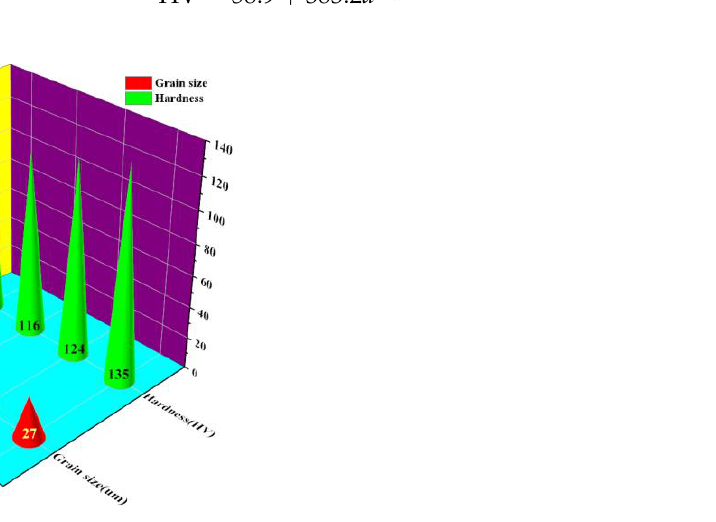
Figure 4. Average grain size and Vickers hardness at different annealed conditions (Fe765, Fe785, and Fe805), with the forged condition (Forg-Fe) as a comparison.